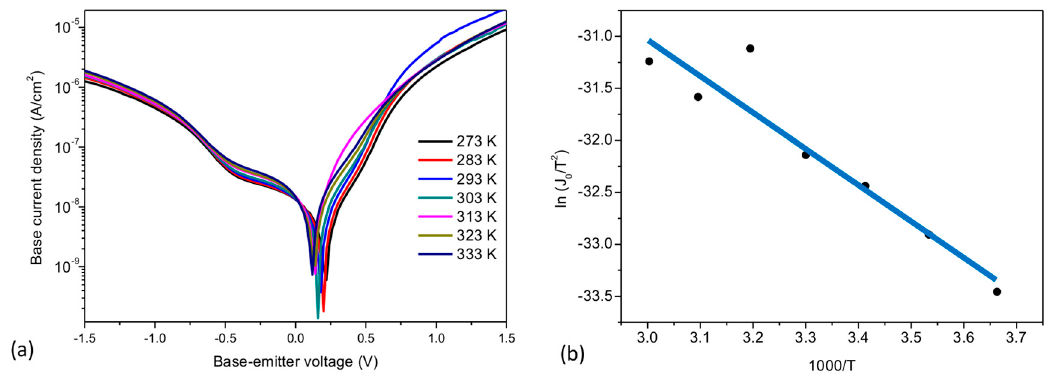
Figure 2. ( a ) Temperature dependent IV characteristics from 273 K to 333 K and ( b ) Richardson plot for the extraction of the base-emitter interface barrier height.